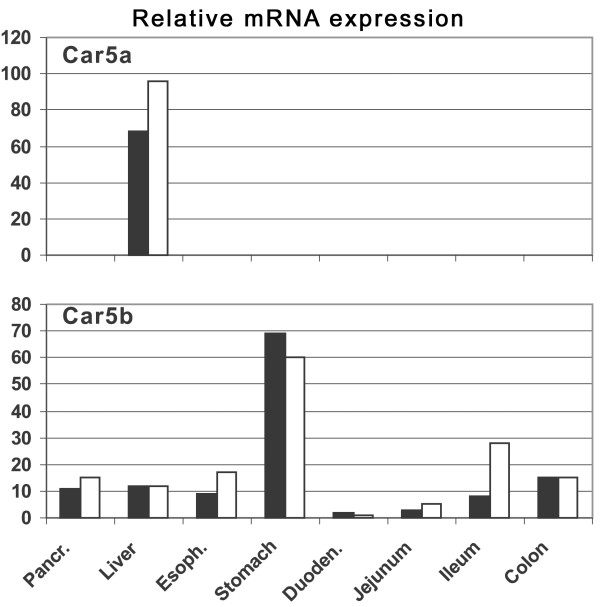
Expression of transcripts for mitochondrial CAs. Solid and open bars represent results obtained from male and female mice, respectively.